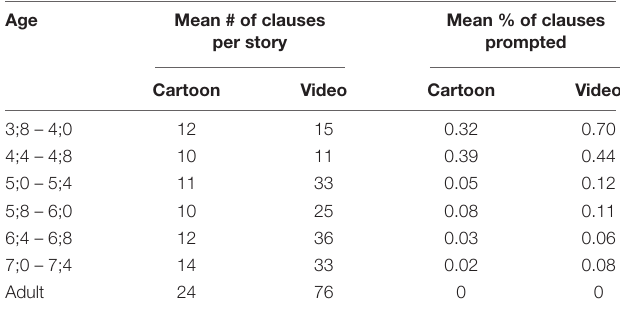
TABLE 2 | Story length and frequency of